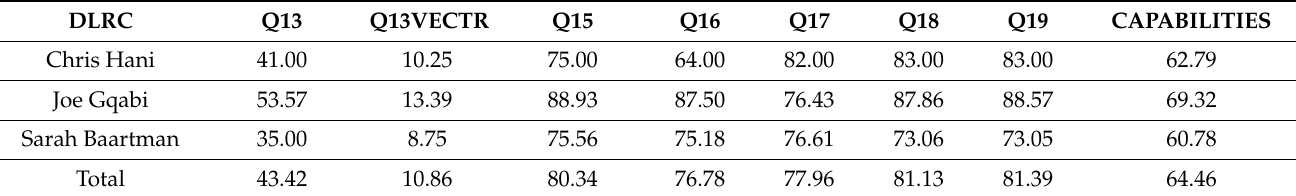
Table 4. Capabilities (average standardized assessment score in